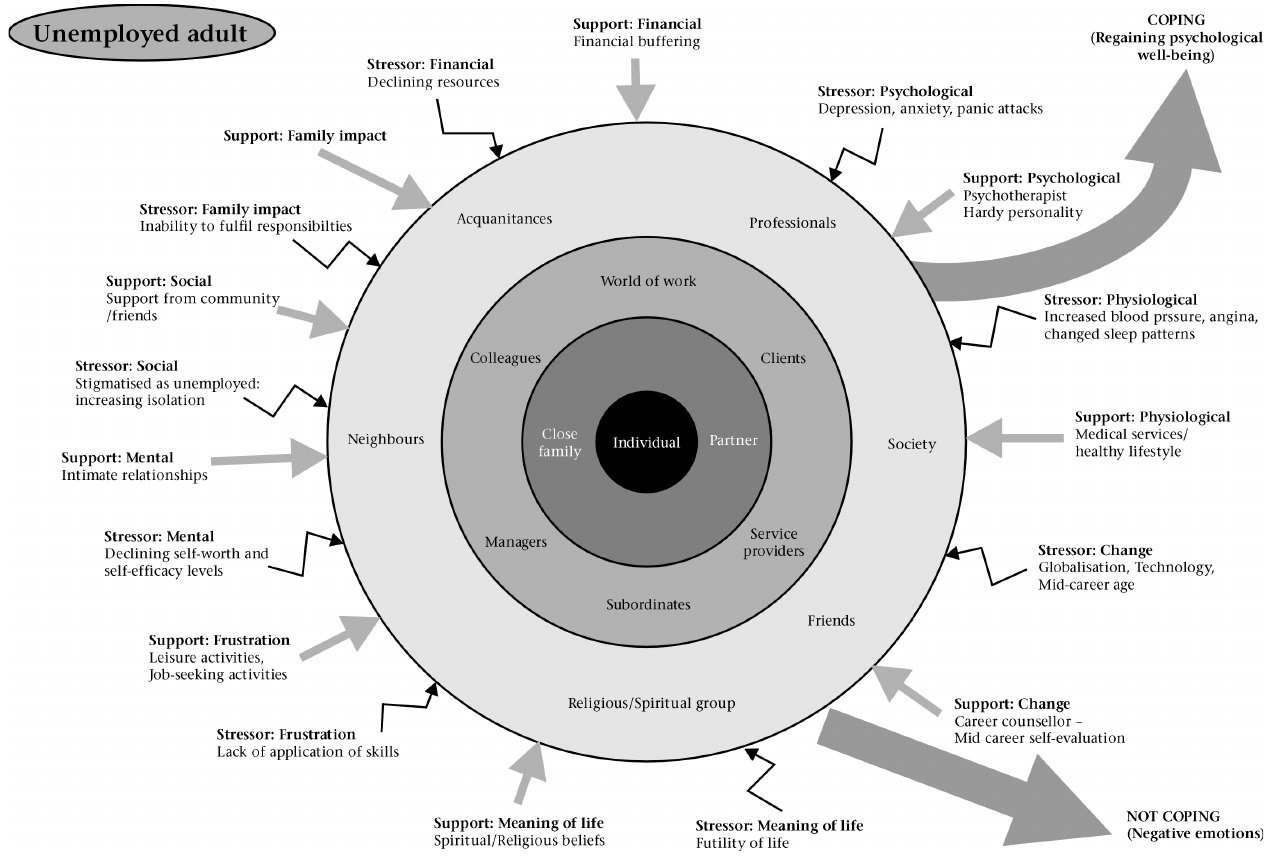
Figure 2: The unemployed adult: Stressors and